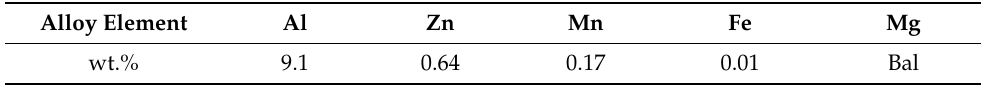
Table 1. Chemical composition of AZ91D cast magnesium alloy. Alloy